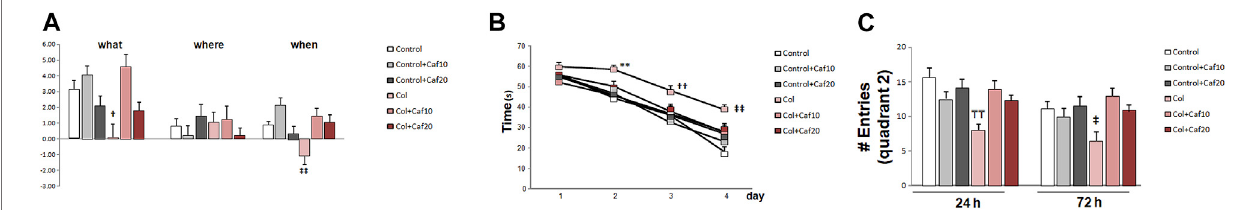
FIGURE1| CaftreatmentlimitscognitiveimpairmentafterGM-IVH. (A) Col-treatedmicewerecompromisedintheNODtestfor “ what ” and “ when ” paradigms.Caf treatmentrevertedthissituation( “ what ” [F (2,200) =2.32and p =0.038; † p =0.014vs.Control+Caf10,Control+Caf20,andCol+Caf10]; “ where ” [F (2,213) =1.28and p = 0.278]; “ when ” [F (2,209) =3.97and p =0.002; ‡‡ p < 0.001vs.Control,Control+Caf10,Col+Caf10,andCol+Caf20].Dataarerepresentativeof10 – 16animals(Control n = 16, Control + Caf10 n = 15, Control + Caf20 n = 15, Col n = 10, Col + Caf10 n = 10, and Col + Caf20 n = 13). (B) Individual day assessment in the acquisition phase of the MWM revealed that GM-IVH impairs learning in the acquisition phase while Caf treatment limits this situation (day 1 [F (5,305) = 1.72 and p = 0.128], day 2 [F (5,307) = 0.315 and ** p = 0.009 vs. rest of the groups], day 3 [F (5,310) = 2.52 and †† p = 0.029 vs. Control, Control + Caf10, and Control+ Caf20], day 4 [F (5,270) = 5.050 and ‡‡ p < 0.01vs.ControlandControl+Caf10].Dataarerepresentativeof10 – 16animals(Controln=16,Control+Caf10n=16,control+Caf20n=16,Coln=10,Col + Caf10 n = 10, and Col + Caf20 n = 12). (C) In the retention phase of the MWM, we analyzed the number of times that mice entered the quadrant where the platform used tobe located (quadrant 2), and weobserved that Col-injured mice entered asigni fi cantly lower number oftimes,whileCaf reversed this situation during retention 1 − − (24 h)[F (2,67) =5.88and p =0.004;T T p =0.003vs.Control,Control+Caf10,Control+Caf20,andCol+Caf10].Asimilarpro fi lewasobservedinretention2(72 h)[F (2,65) = 4.60 and p = 0.013; ‡ p = 0.047 vs. Control + Caf10 and Control + Caf20]. Data are representative of 9 – 16 animals (Control n = 16, Control + Caf10 n = 15, Control + Caf20 n = 15, Col n = 9, Col + Caf10 n = 9, and Col + Caf20 n = 13).